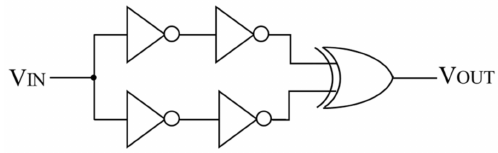
Figure 4. The schematic of the window